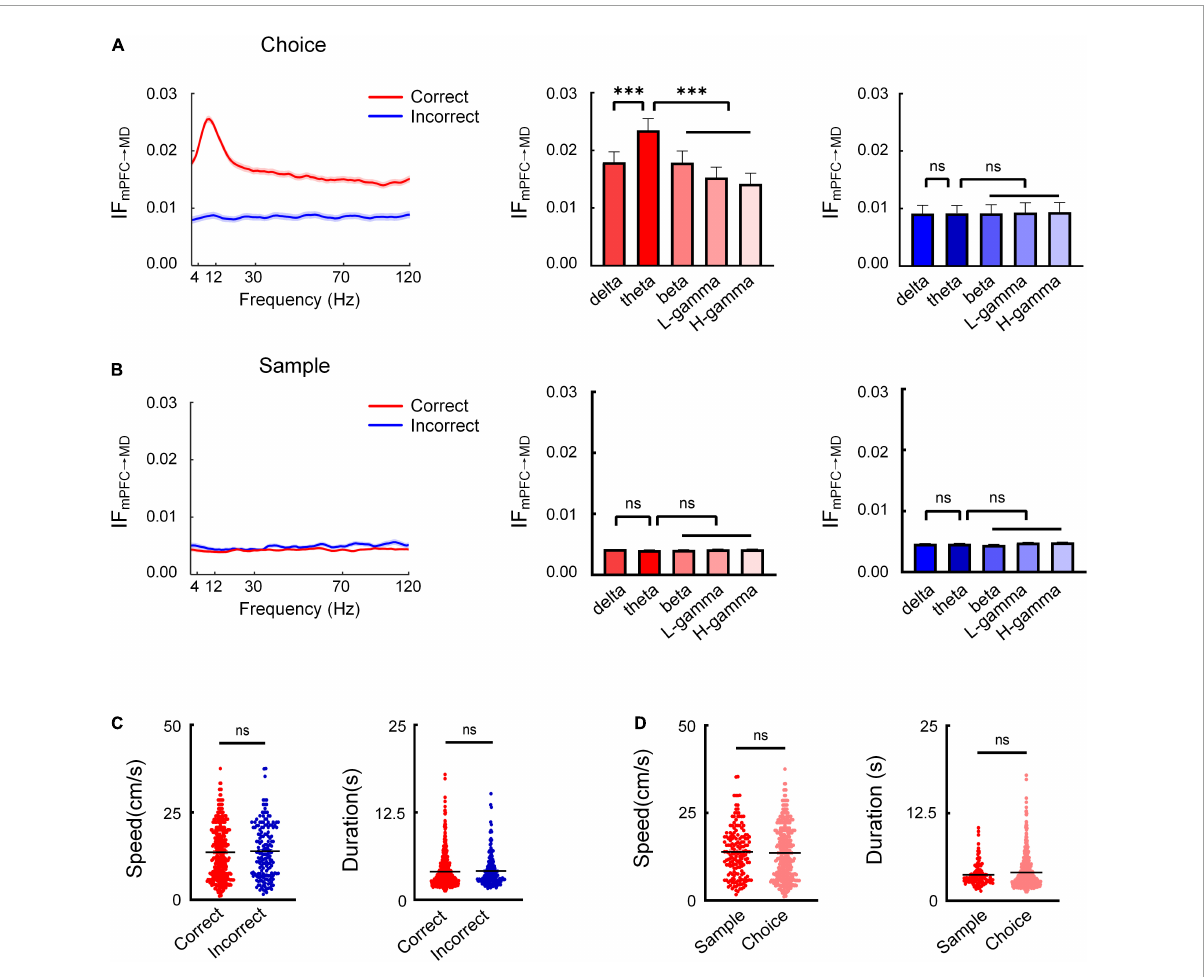
FIGURE2 Theta-band information flow from mPFC to MD is prominent during the choice phase. (A) The average information flow across different frequencies during the choice phase. (Left) Information flow as a function of frequency across subjects ( n = 8 mice). The red and blue curves represent the information flow on correct and incorrect trials, respectively. (Right) Comparison of information flow across different frequencies on correct and incorrect trials (correct: two-way AONVA, F = 55.02, P < 0.001; incorrect: two-way ANOVA, P > 0.05). (B) Same as (A) , but for the sample phase (correct: two-way AONVA, P > 0.05; incorrect: two-way ANOVA, P > 0.05). (C) Running speed and duration on correct and incorrect trials showed no significant difference (Mann–Whitney test, speed: P > 0.05; duration: P > 0.05). (D) Running speed and duration between the choice and sample phases showed no significant difference (Mann–Whitney test, speed: P > 0.05; duration: P > 0.05). ∗∗∗ P < 0.001, ns, not